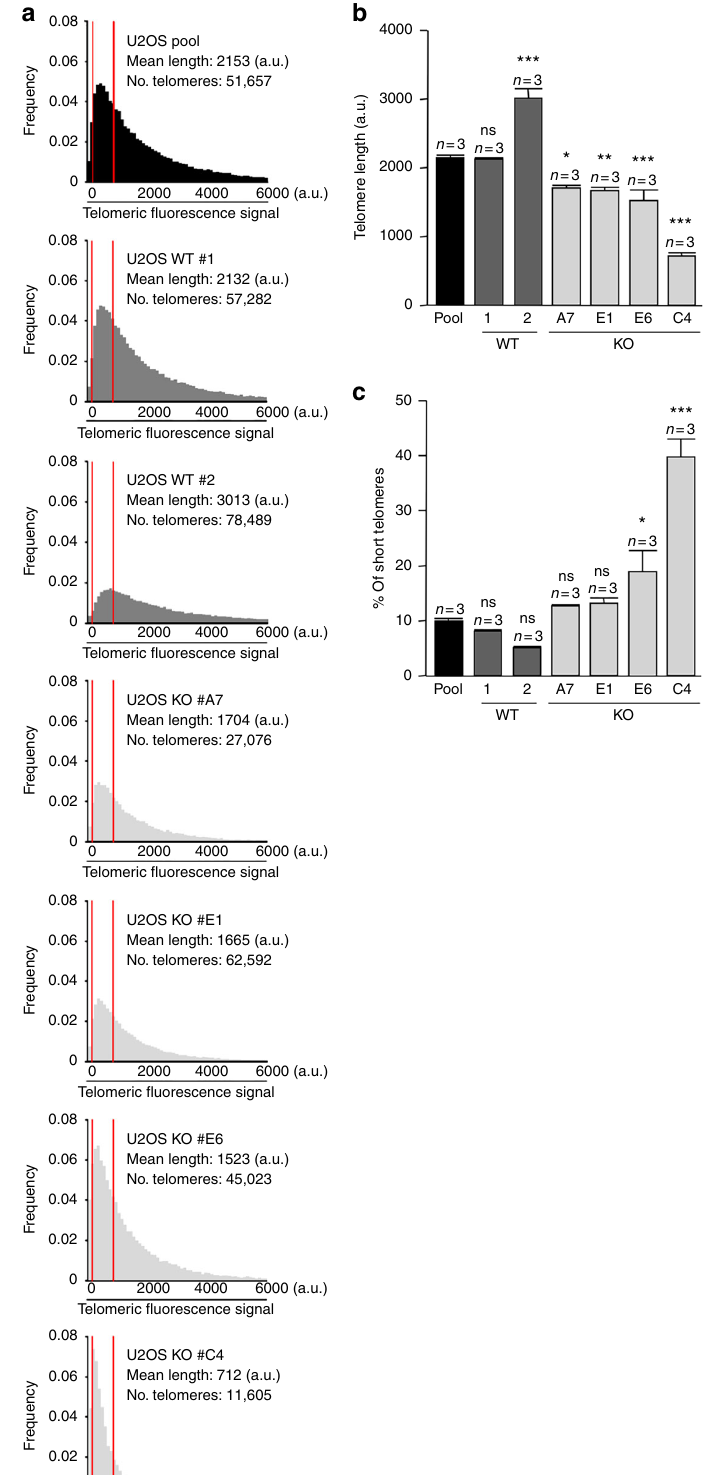
Fig. 2 Deletion of the 20q-TERRA locus decreases telomere length. a Representative frequency graphs of telomere length distribution (a.u.) measured in the U2OS WT pool (black), in the WT clones (#1 and 2; dark gray), and in the 20q-TERRA KO clones (#A7, E1, E6, and C4; light gray). The mean telomere length and the number of telomeres analyzed is shown. The red lines are arbitrary lines placed in the exact same position in each frequency graph to visualize differences between samples. b Graph showing the quanti fi cation of the mean telomere length in the U2OS cells WT pool, the WT expanded clones (#1 and 2), and in the 20q-TERRA KO clones (#A7, E1, E6, and C4) by HT-Q-FISH (mean values±s.e.m., n = technical replicates). c Graph showing the percentage of short telomeres in the same settings. Short telomeres are considered those in the 10% percentile of the total telomere length distribution (mean values±s.e.m., n = technical replicates). One-way ANOVA with Dunnett ’ s post test was used for the statistical analysis (* p <0.05, ** p <0.01, and *** p